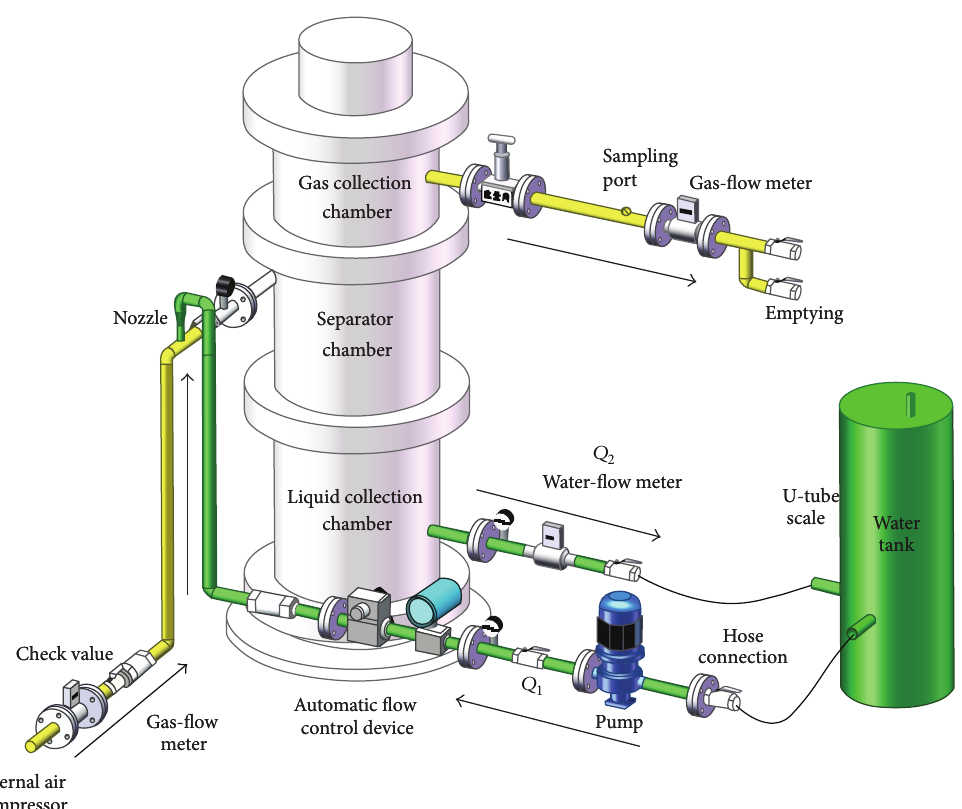
Figure 2: The system diagram of the experiment setup.